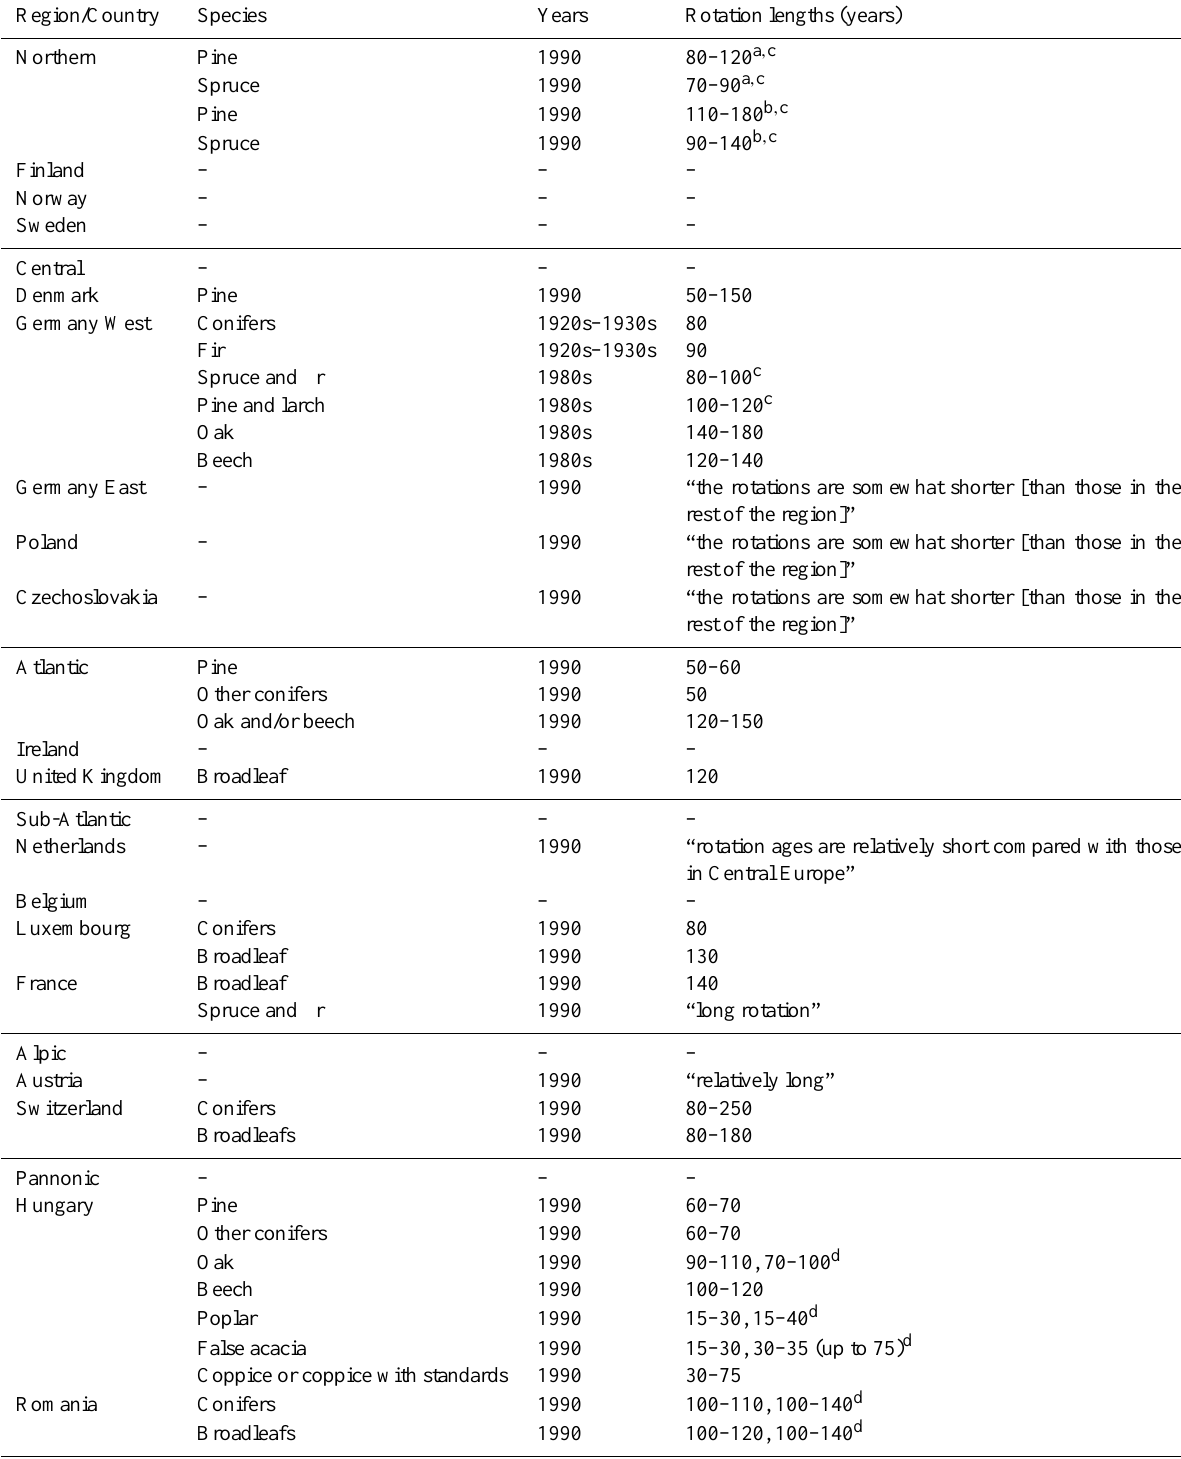
Table 4. Rotation length by tree species and country collected from Kuusela (1994). If an explicit year is not given, the year 1990 (the date of the latest data set used) is assumed. Region names are listed in bold font and are defined in Kuusela (1994), from which the quotations are also